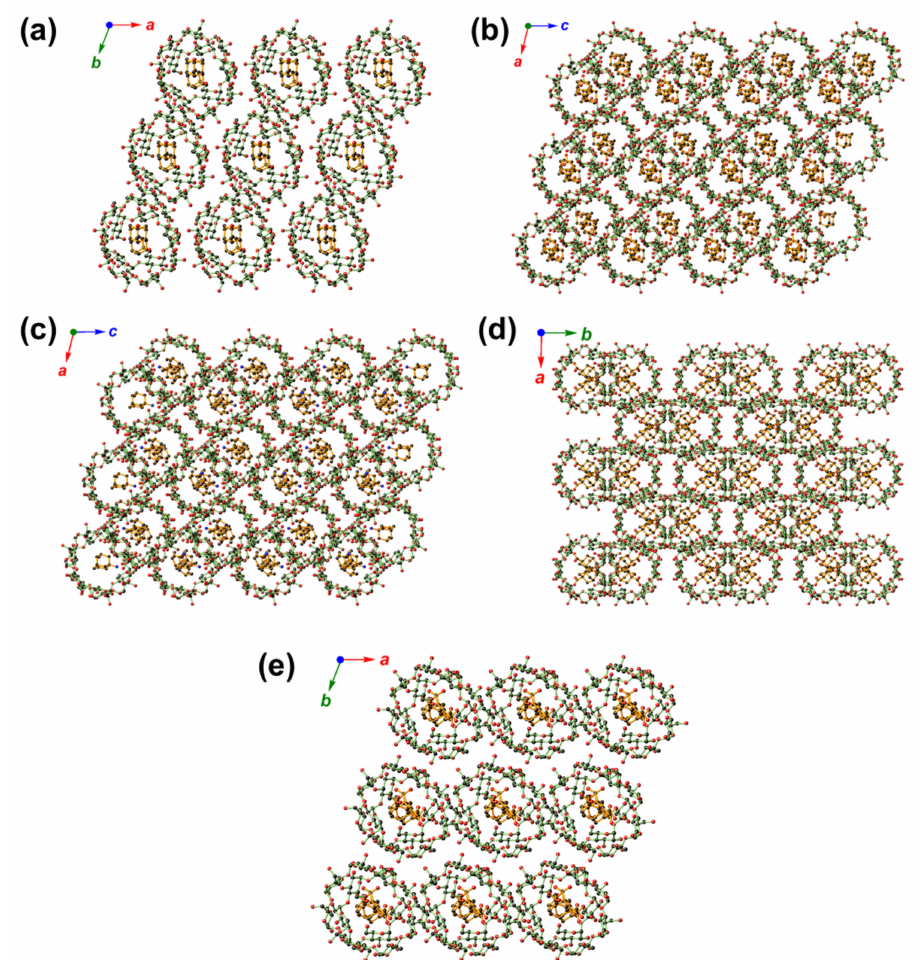
Figure 4. The crystal packing diagrams of 1 (( a ); along c direction), 2 (( b ); along b direction), 3 (( c ); along b direction), 4 (( d ); along c direction), and 5 (( e ); along c direction), showing similarities and differences in their packing patterns. Color codes: O (red), N (blue), and C